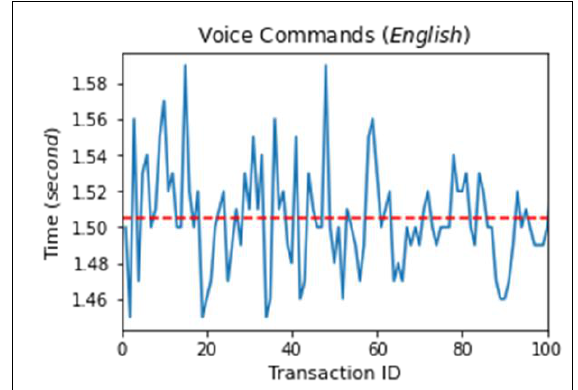
Figure 6. Voice Commands in English